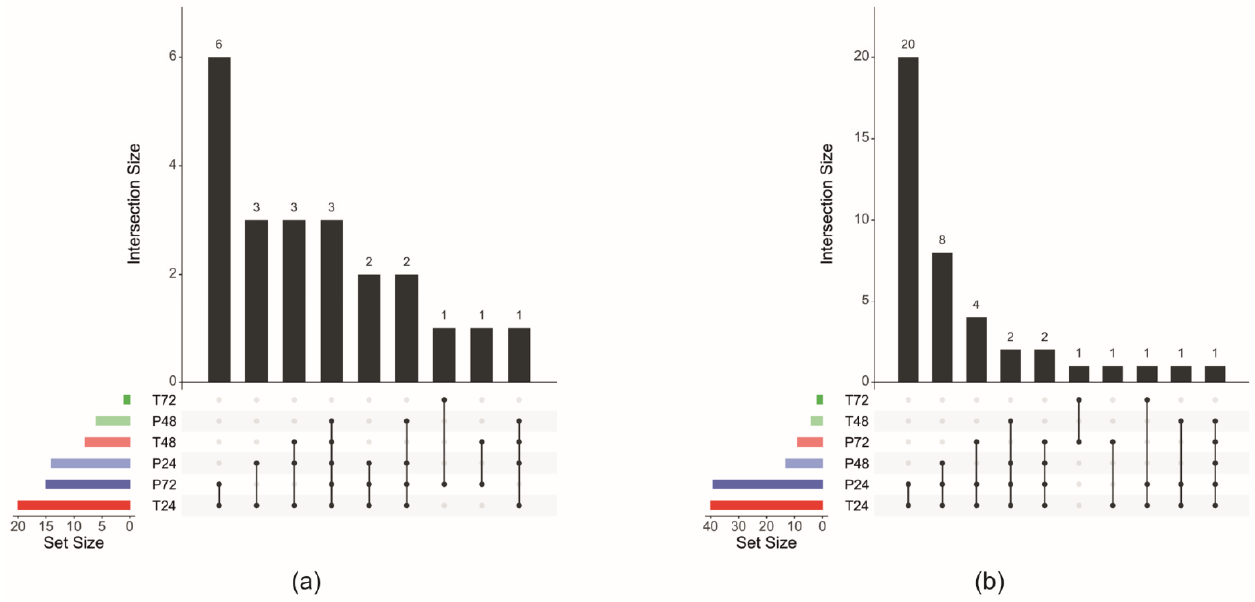
Figure 1. UpSet plot of the intersection of ( a ) up-regulated and ( b ) down-regulated genes during the early interaction of tomato roots with Trichoderma harzianum T22 or Pseudomonas fluorescens Pf-16. The numbers of genes (black bars) are indicated for each time point (colored bars) intersection. T = T. harzianum strain T22; P = P. fluorescens strain Pf-16. Tomato roots were sampled at 24, 48, and 72 h post-inoculum.